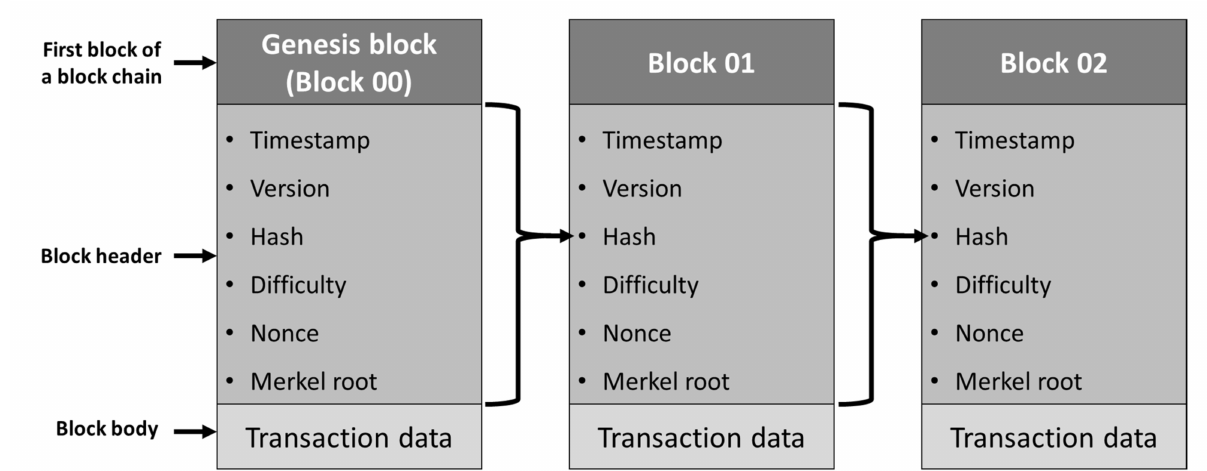
Figure 3. Structure of a block in